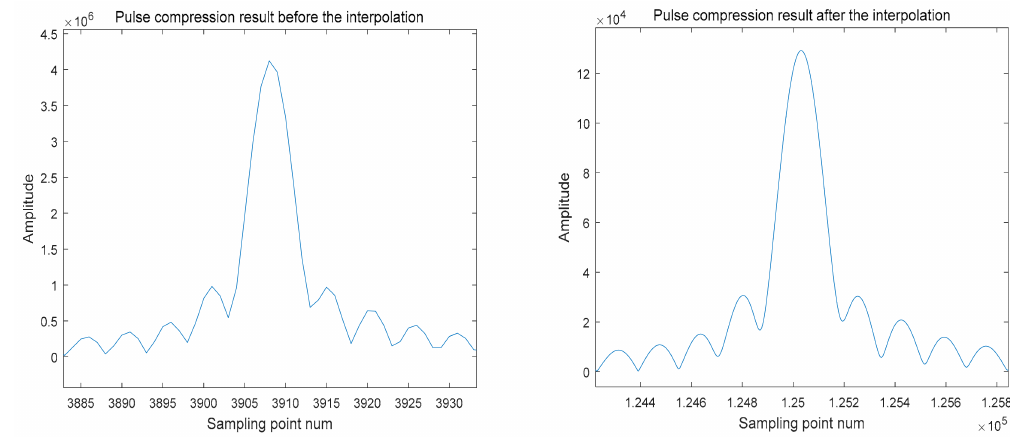
Figure 11. The comparison of the pulse compression results before and after